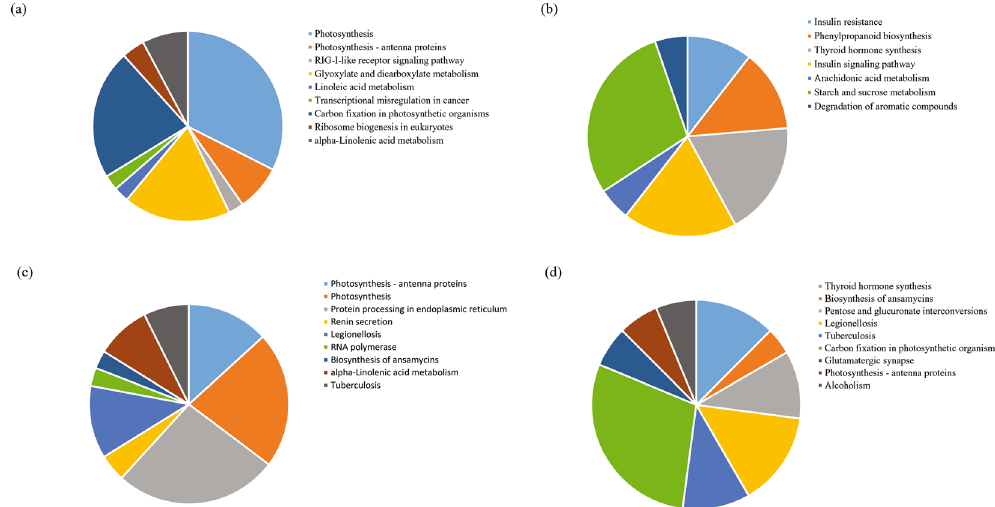
Figure 3. Analysis of KEGG enrichment in the four groups. ( a ) KEGG enrichment in ‘Tianyuanhong’ fruits at 70 vs. 100 DAF (group B/A). ( b ) KEGG enrichment in ‘Tianyuanhong’ vs. ‘Yongfengyihao’ fruits at 70 DAF (group D/C). ( c ) KEGG enrichment in ‘Tianyuanhong’ vs. ‘Yongfengyihao’ fruits at 100 DAF (group A/C). ( d ) KEGG enrichment in ‘Yongfengyihao’ fruits at 70 vs. 100 DAF (group B/D).